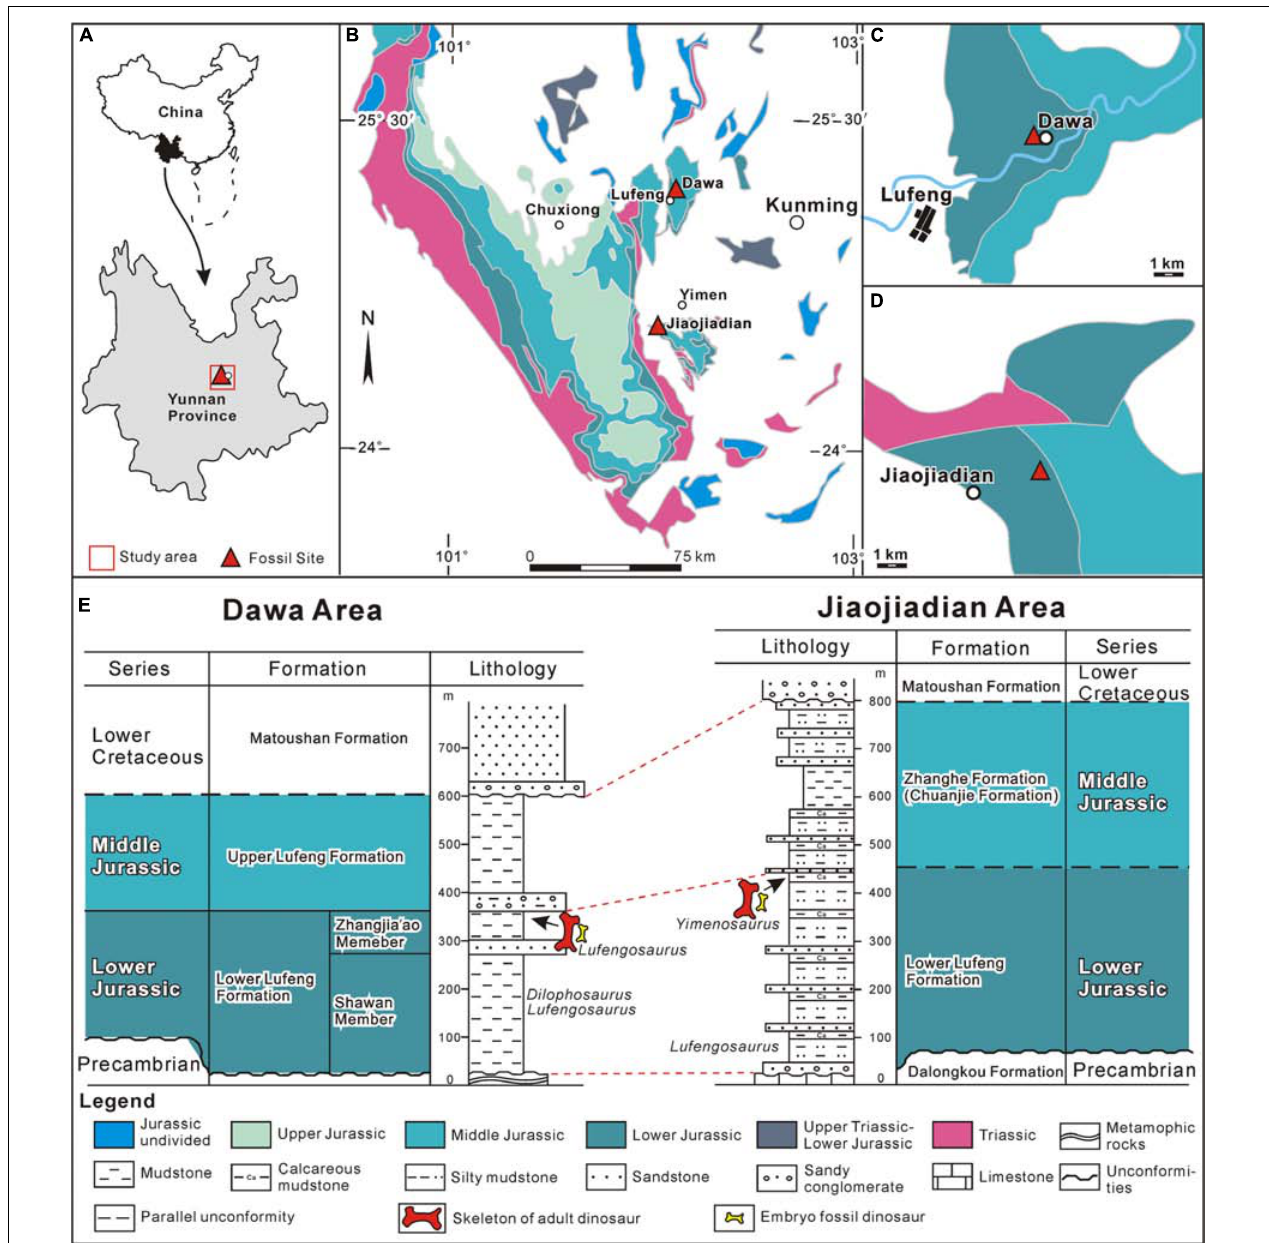
FIGURE 1 | Location and stratigraphy of Dawa Lufengosaurus and Jiaojiadian Yimenosaurus fossil sites. (A) Geographic location of the study area. (B) Distribution of the Jurassic strata in central Yunnan Province and the location of the two dinosaur sites (70 Km apart). (C) Sketched geologic map of Dawa area. (D) sketched geologic map of Jiaojiadian area. (E) Stratigraphic columns of Dawa and Jiaojiadian fossil sites and their